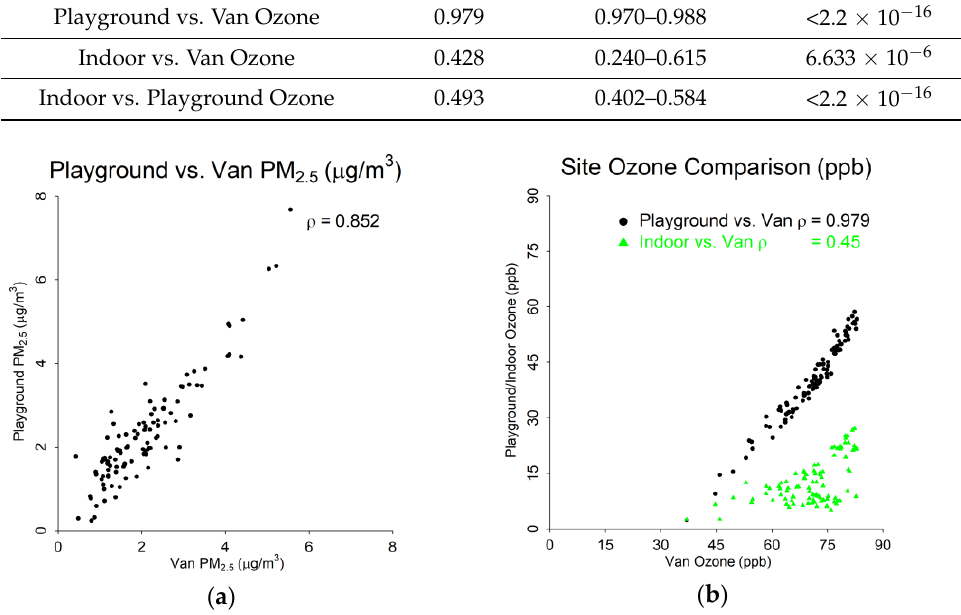
Figure 8. Site pollutant readings comparisons for Bonneville Phase 1 campaign (13–27 September 2019) for ( a ) fine particulate matter and ( b ) ozone.